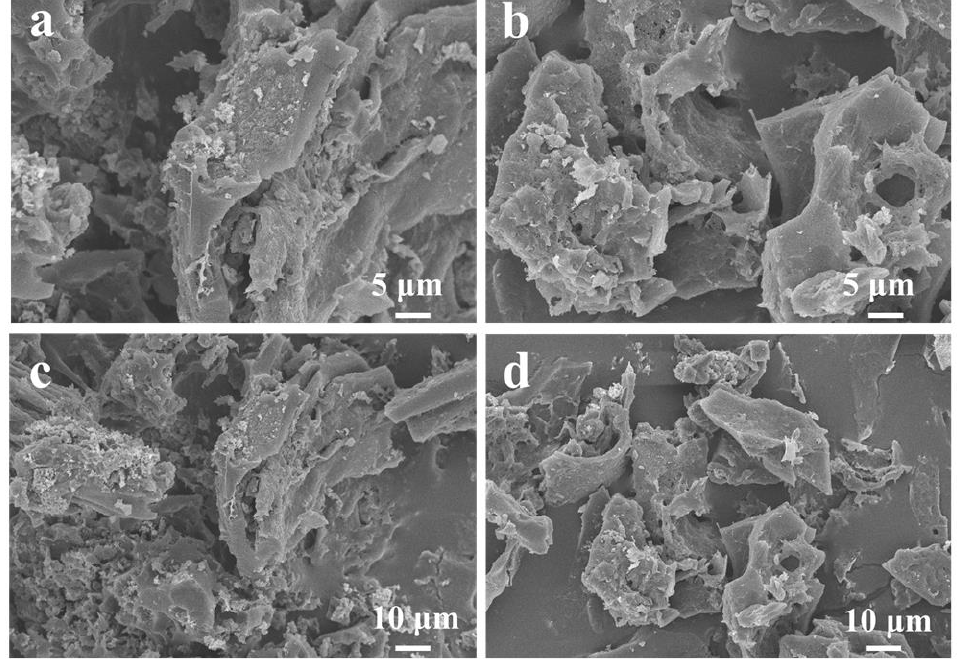
Figure 3. SEM images of ( a , c ) AC-12 and ( b , d ) AC-12@CD. FT-IR spectra of AC-12, AC-12@CD, and AC-12@CD-Cu 2+ (AC-12@CD after adsorp- tion of Cu 2+ ) are shown in Figure 4a. Wide peaks at 3428 cm −1 were assigned as a tensile